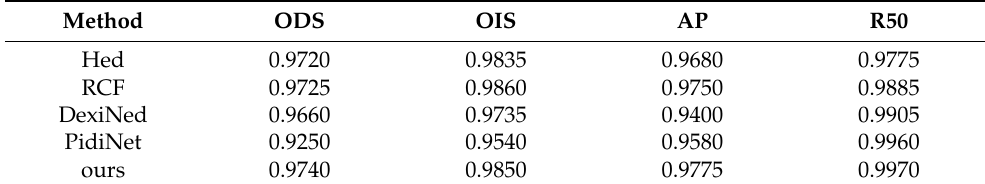
Table 2. Evaluation indexes of different methods.